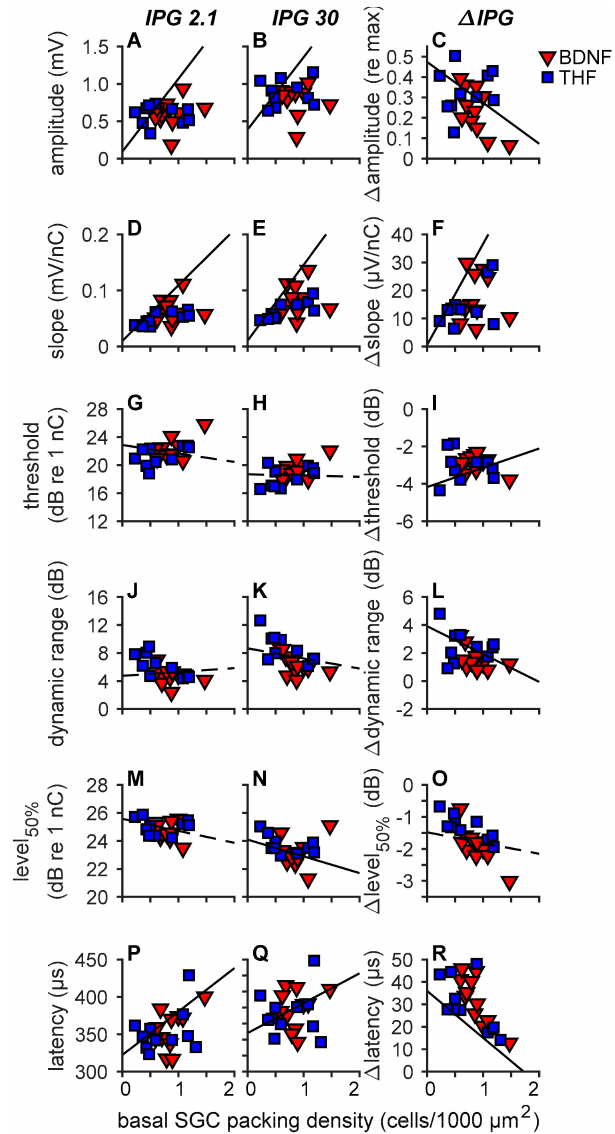
Figure 8. eCAP characteristics of individual animals as a function of basal SGC packing density. The inter-phase gap (IPG) was 2.1 µ s in the left column and 30 µ s in the middle column. The di ff erence between the two (i.e., the IPG e ff ect) is shown in the third column. Lines represent regression on NH, 2WD (from Ramekers et al. [48]) and untreated 6WD control animals only. Solid lines represent an R 2 with a p value of < 0.05, dashed lines a p value of ≥ 0.05. ( A – C ), maximum amplitude; ( D – F ), slope; ( G – I ), threshold; ( J – L ), dynamic range; ( M – O ), level 50% ; ( P – R ), N 1 latency. Data of the 2WD animals was used from Ramekers et al. [48]. BDNF, n = 11; THF, n = 10 ( n = 11 for latency). Error bars represent